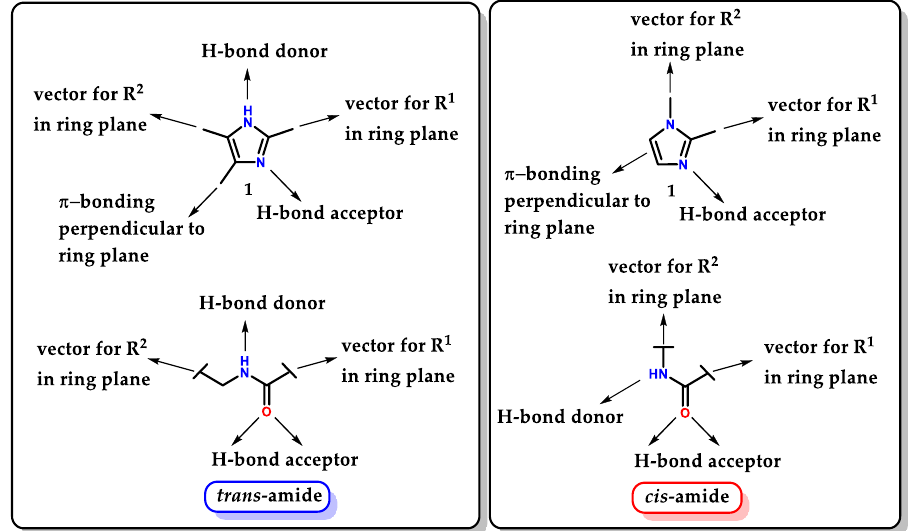
Figure 33. Isosteric relationship between imidazole 1 and trans/cis